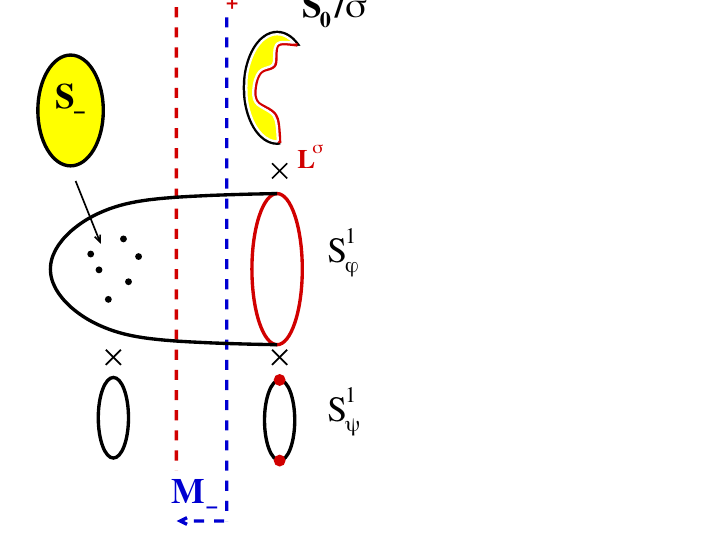
Figure 3 . A cartoon of M , its K3 (cid:12)bration, the (cid:12)xed locus of (cid:27) , and its TCS decomposition into M (cid:0) and M + . Note that except for the action of (cid:27) , the K3 (cid:12)bration is trivial on M + . structure on which (cid:27) acts holomorphically. This hyper-K(cid:127)ahler rotation ’